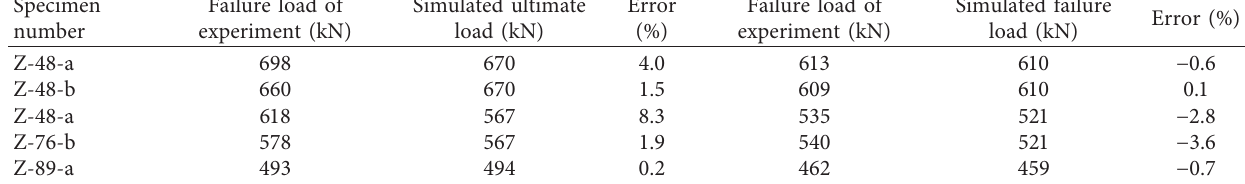
Table 3: Comparison of experimental data and simulated data.